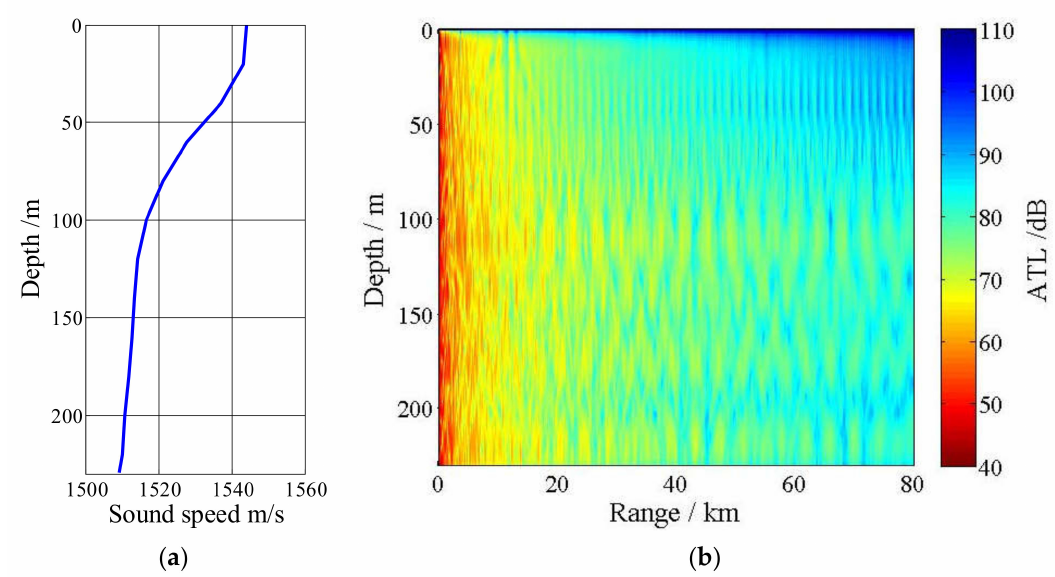
Figure 2. Simulation parameters and sound propagation in shallow water: ( a ) The sound speed profile; ( b ) The average transmission